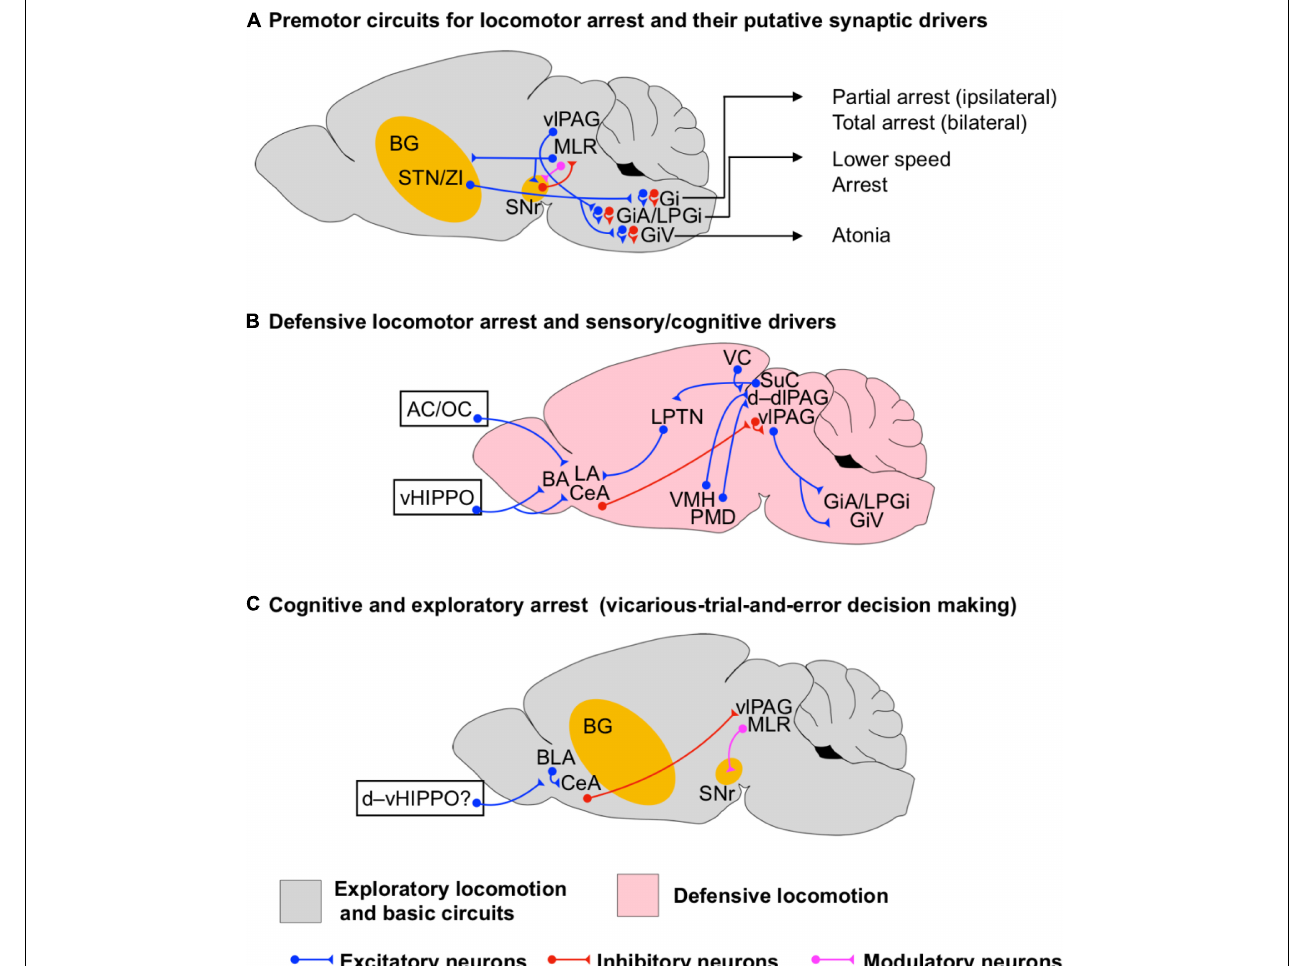
FIGURE 3 | Circuits for locomotor arrest during exploratory and defensive states. (A) Scheme of the premotor neuronal circuits underlying locomotor arrest and their putative synaptic drivers. Different types of locomotion arrest executed by premotor neuronal circuits in the medullary reticular formation are indicated (arrows). (B) Scheme of the neuronal circuits underlying the initiation of defensive locomotor arrest. Sensory and cognitive synaptic drivers are shown such as from auditory cortex (AC), olfactory cortex (OC), and the ventral hippocampus (vHIPPO). (C) Scheme of the neuronal circuits underlying cognitive arrest during spatial exploration, such as that seen during exploratory decision making. Potential synaptic drivers from the dorsoventral hippocampus (d–vHIPPO) involved in non-defensive spatial memory processing are shown. The question mark indicates that the actual synaptic path from d–vHIPPO to BLA/CeA underlying decision-making-driven arrest has not been identified. The BG circuits are highlighted in yellow to indicate that they are involved in the initiation of a particular state even if they are not fully shown for